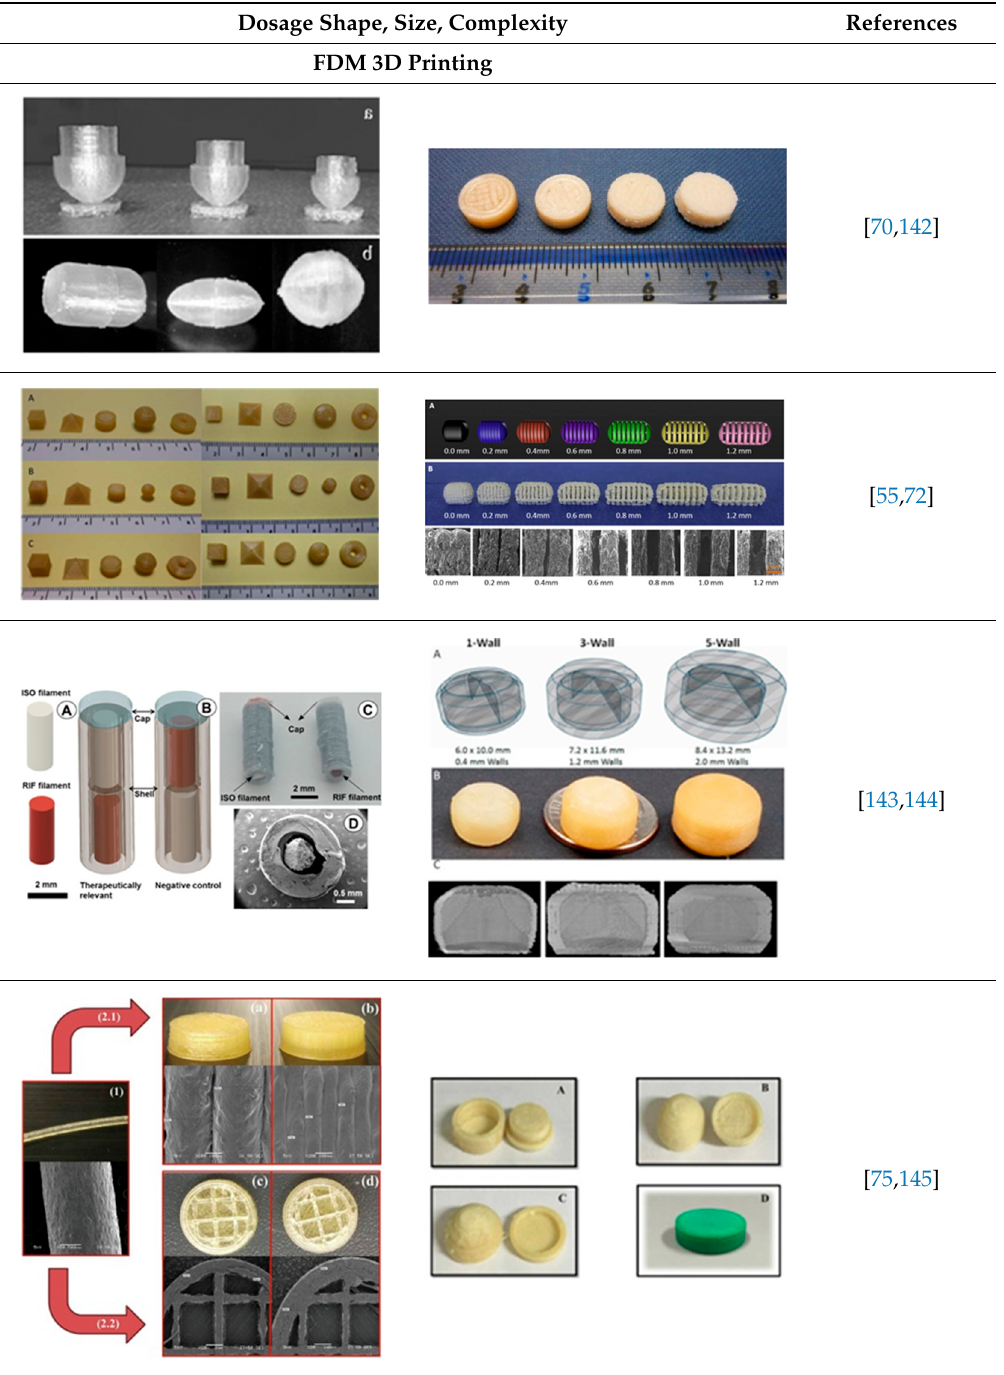
Table 4. Pharmaceutical dosages of di ff erent shapes or forms, sizes and complexities that had been 3D Table 4. Pharmaceutical dosages of different shapes or forms, sizes and complexities that had been Table 4. Pharmaceutical dosages of different shapes or forms, sizes and complexities that had been Table 4. Pharmaceutical dosages of different shapes or forms, sizes and complexities that had been Table 4. Pharmaceutical dosages of different shapes or forms, sizes and complexities that had been Table 4. Pharmaceutical dosages of different shapes or forms, sizes and complexities that had been Table 4. Pharmaceutical dosages of different shapes or forms, sizes and complexities that had been printed and reported in the literature. Table 4. Pharmaceutical dosages of different shapes or forms, sizes and complexities that had been Table 4. Pharmaceutical dosages of different shapes or forms, sizes and complexities that had been 3D printed and reported in the literature. 3D printed and reported in the literature. 3D printed and reported in the literature. 3D printed and reported in the literature. 3D printed and reported in the literature. 3D printed and reported in the literature. 3D printed and reported in the literature. 3D printed and reported in the